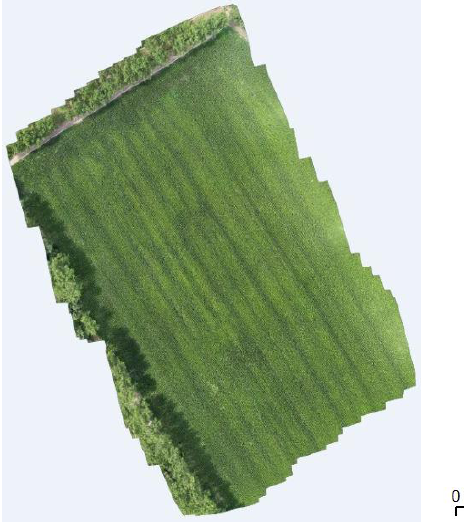
Figure 5. RGB orthophoto on maize crop, obtained with Agisoft PhotoScan with exterior orientation parameters from CALGE.